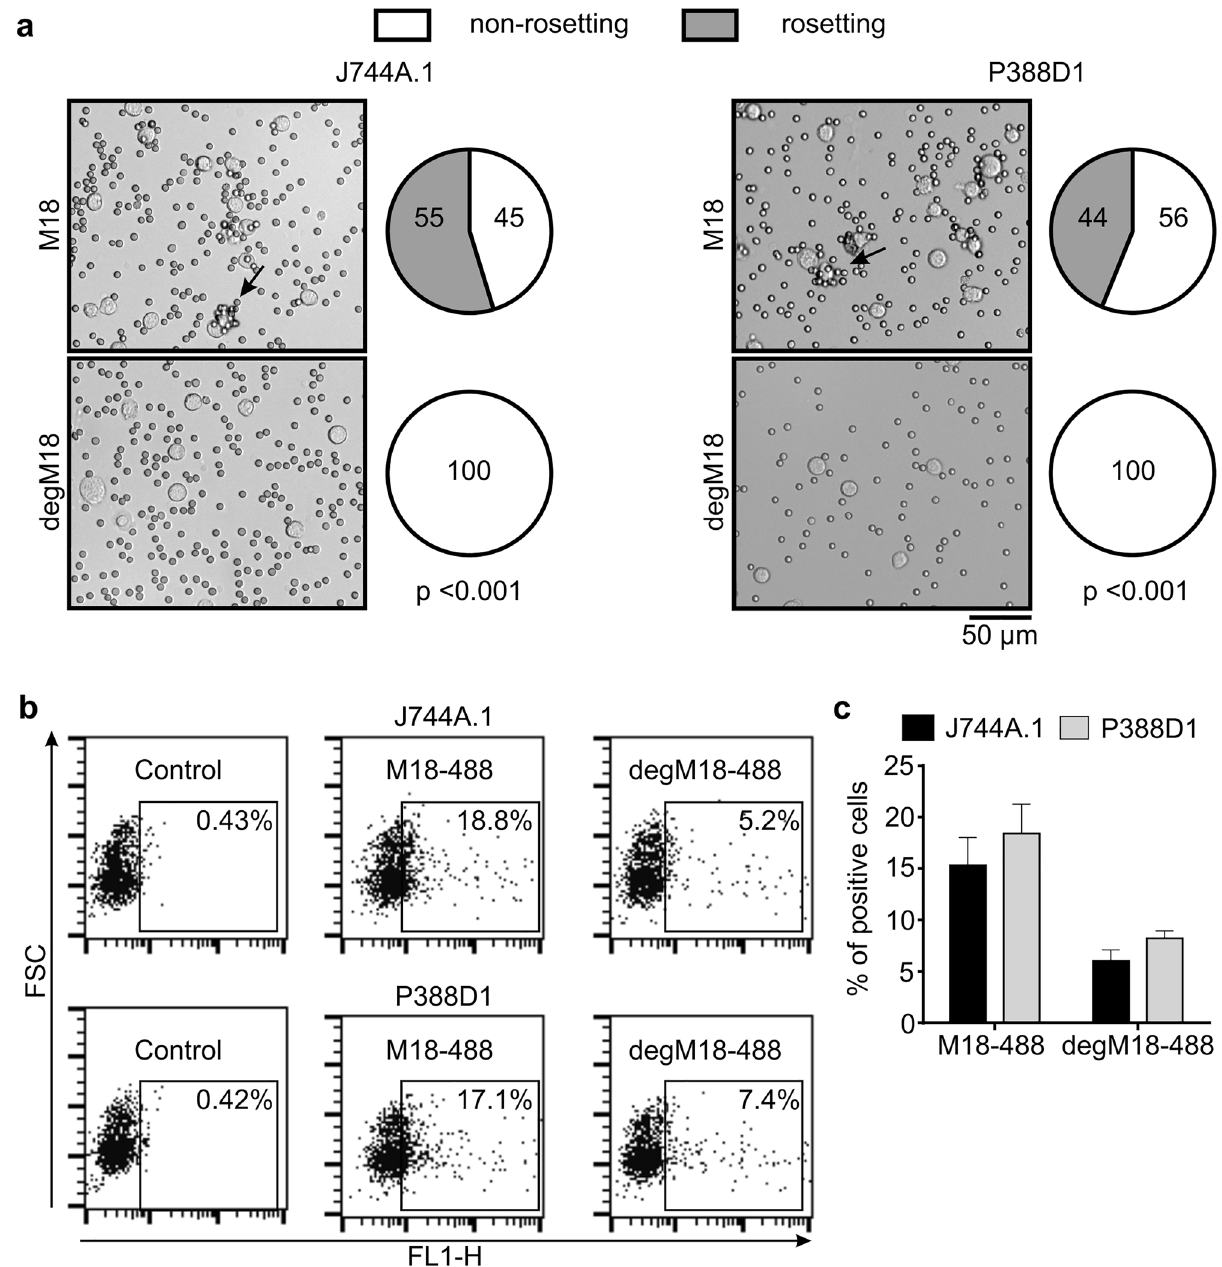
Figure 1. Deglycosylation of mIgG3 prevents its binding to J774A.1 and P388D1 cells. ( a ) Erythrocyte rosetting around J774A.1 or P388D1 cells coated with the M18 mIgG3 antibody specific to antigen B of the human ABO blood group system. The cells were coated with native or deglycosylated M18 (degM18). The small cells are group B human erythrocytes, whereas the large bright cells are J774A.1 or P388D1 cells. The arrows point to exemplary rosettes. Representative microscope images of three independent experiments are shown. The pie charts display the percentage of rosetting and non-rosetting cells observed in three different fields in the same representative experiment. ( b , c ) Binding of M18-488 to J774A.1 or P388D1 cells analyzed using flow cytometry. The cells were stained with fluorescently labeled native or degM18. The dot plots show representative results of three independent experiments. ( c ) Average values ± SD of the three independent experiments described in ( b